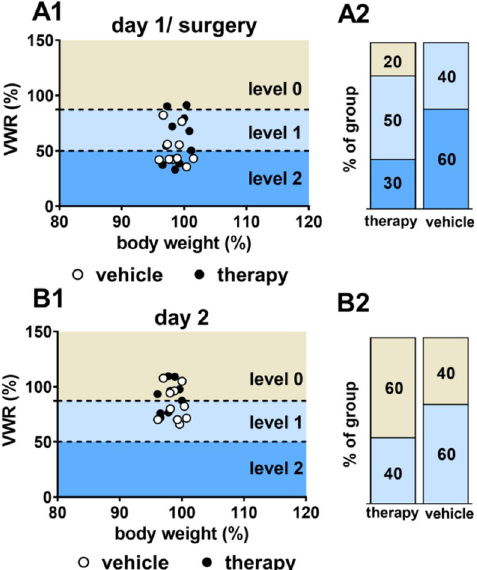
Fig 8. Severity level cluster for surgical intervention and recovery. Allocation to levels within cluster model for the day of surgery (A; therapy group: 30% level 2, 50% level 1, 20% level 0; vehicle group: 60% level 2, 40% level 1) and the first day of recovery (B; therapy group: 40% level 1, 60% level 0; vehicle group: 60% level 1, 40% level 0).